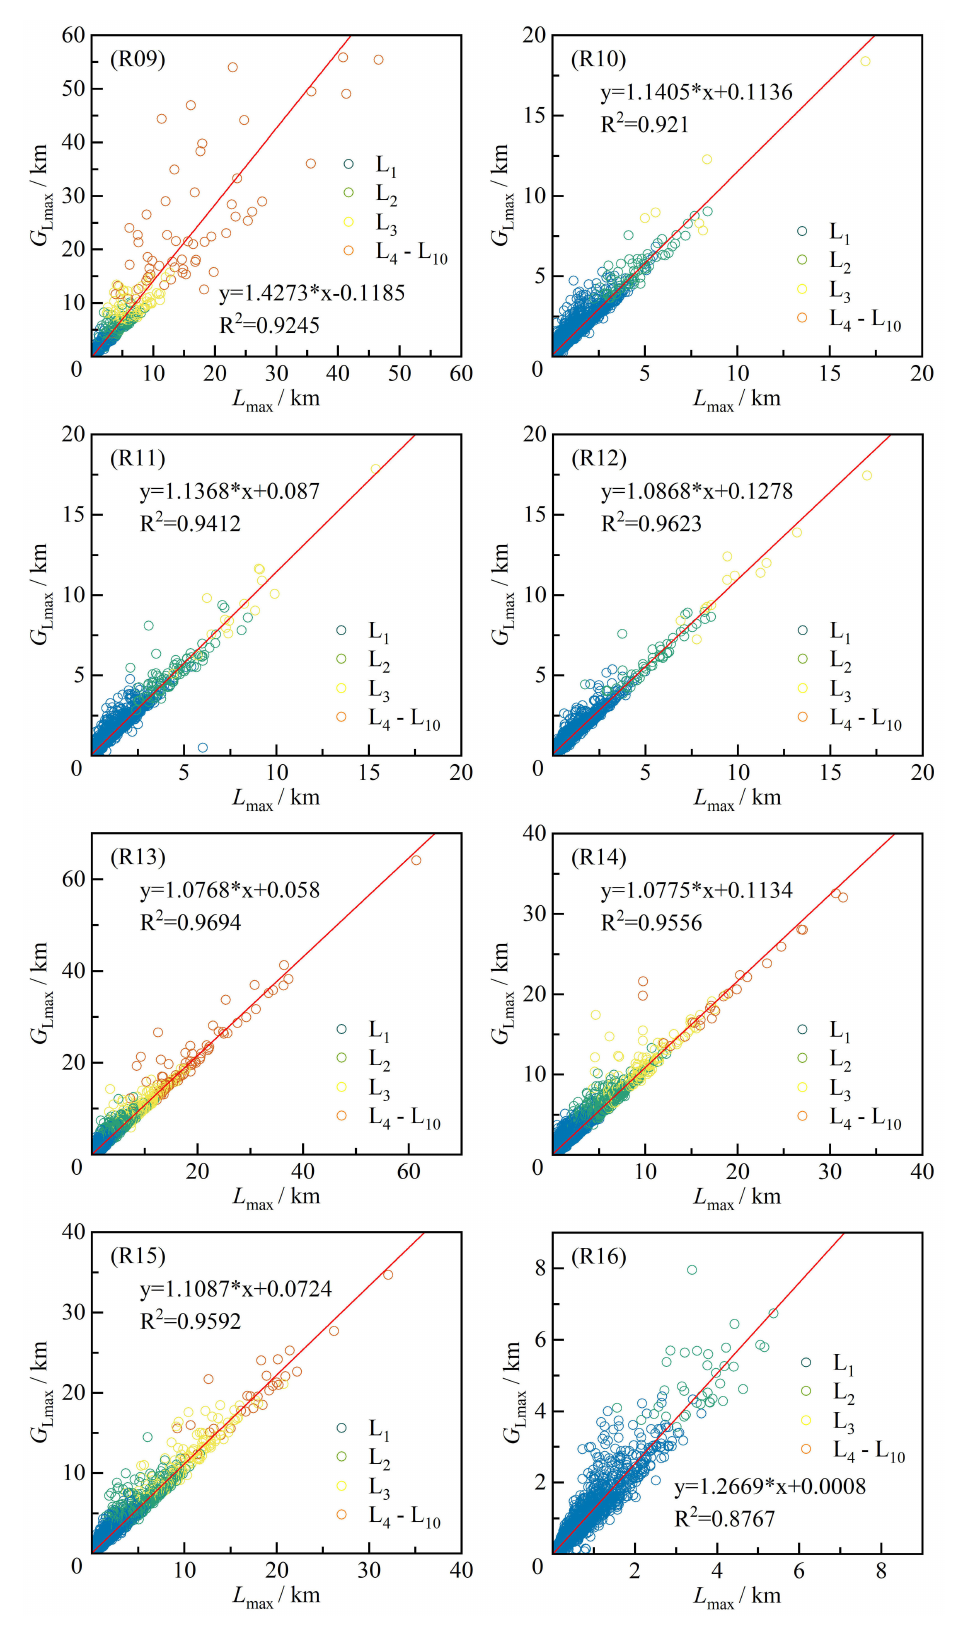
Figure B1. https://doi.org/10.5194/essd-14-3889-2022 Earth Syst. Sci. Data, 14, 3889–3913,